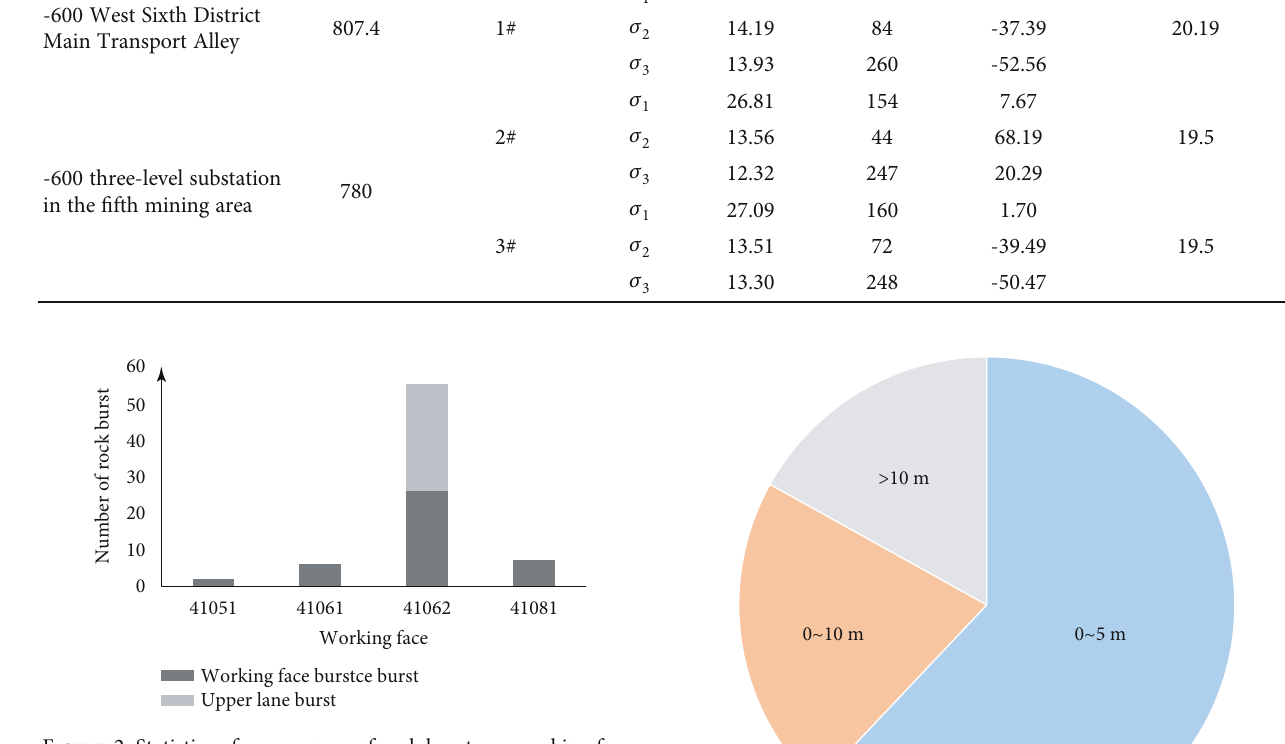
Figure 2: Statistics of occurrences of rock bursts on working face.